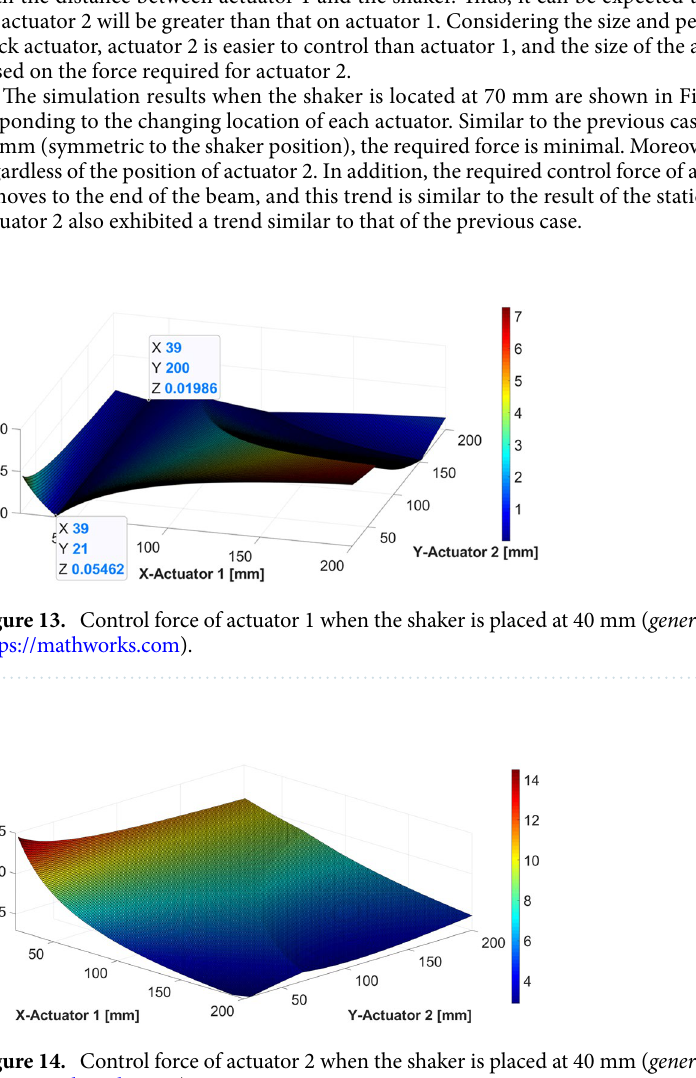
Figure 14. Control force of actuator 2 when the shaker is placed at 40 mm ( generated with MATLAB R2018b, https:// mathw orks.